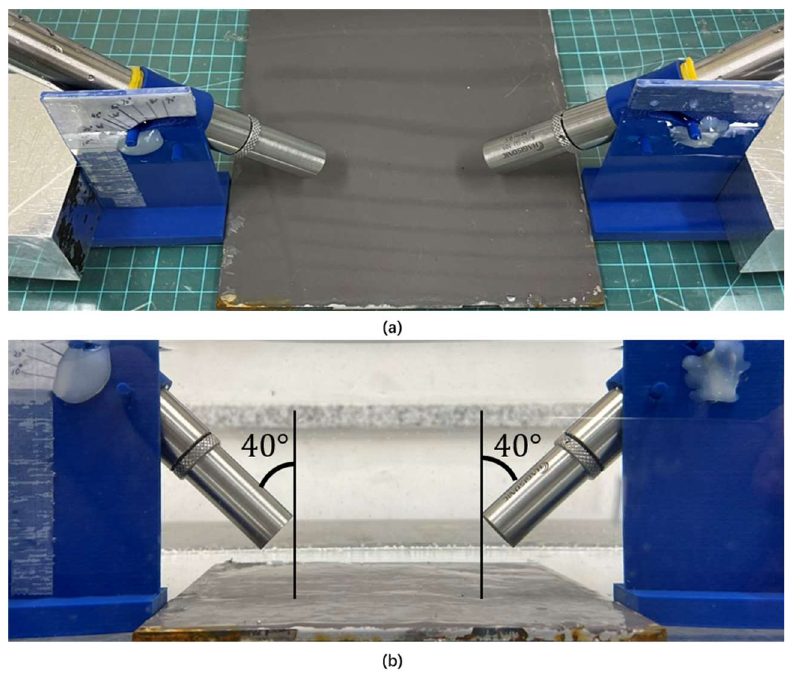
Figure 4. Guided Wave Generation Experiments in Water: ( a ) top view; ( b ) front view.